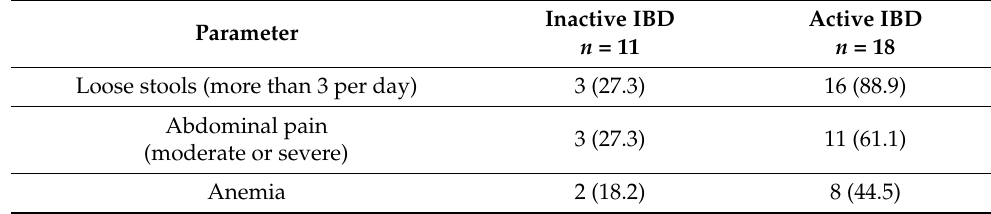
Table 2. Clinical manifestations of patients with inactive and active